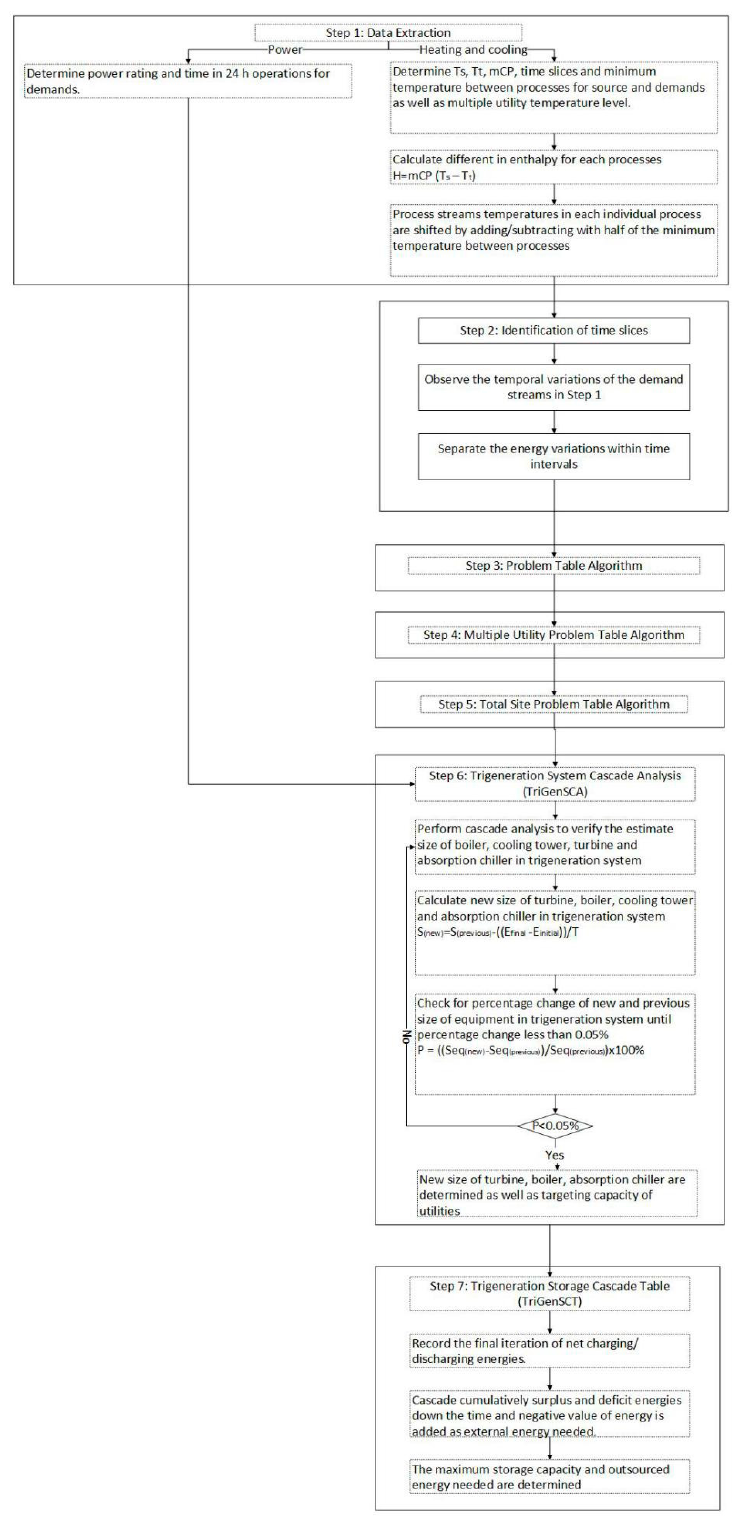
Figure 1. Overview of the suggested systematic approach.